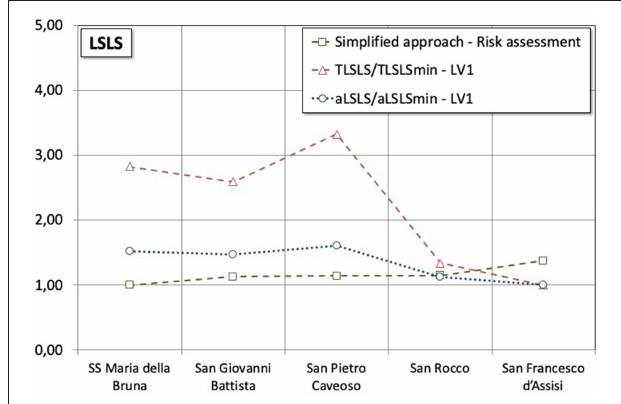
FIGURE 8 | Comparisons among the results obtained with the LV1 and LV2 methods, and with the seismic risk assessment method